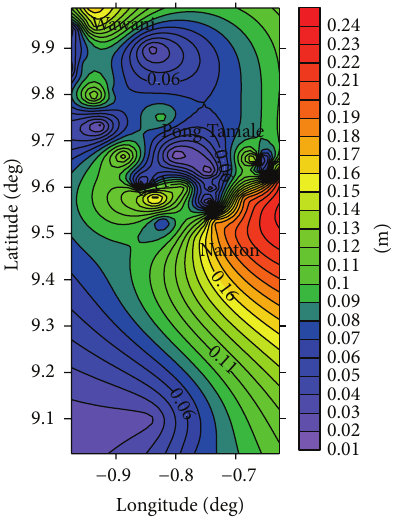
Figure 5: Spatial distribution of estimated groundwater recharge in Savelugu and surrounding subcatchments of the White Volta